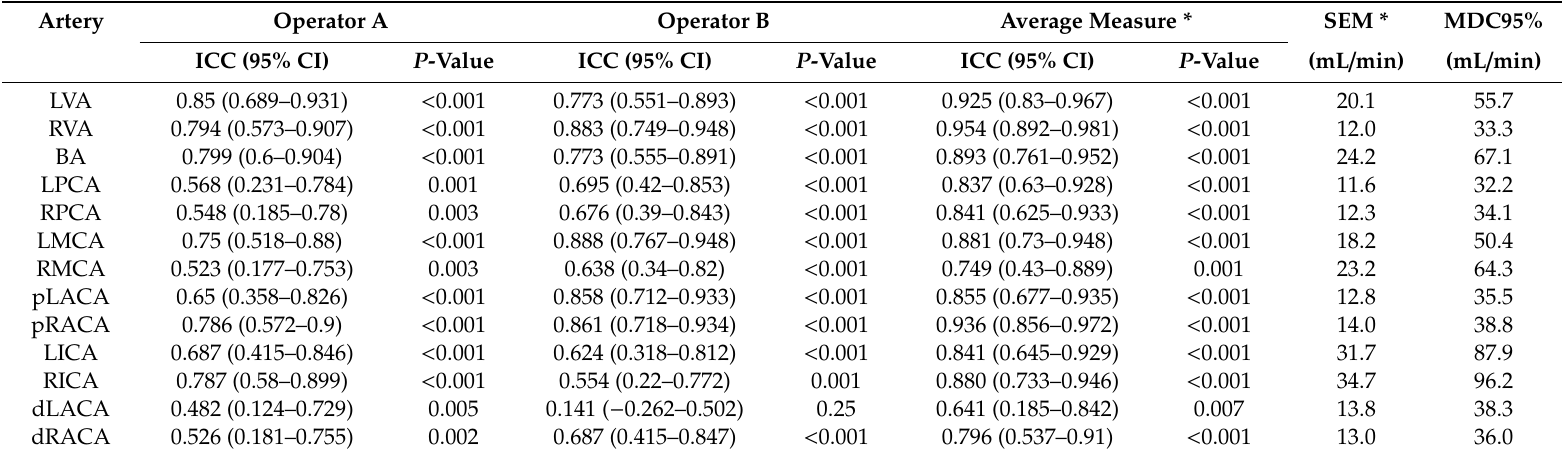
Table 3. Intraclass correlation coe ffi cients of intra-rater comparisons of volume blood flow measurements for each cerebral artery in the circle of Willis.